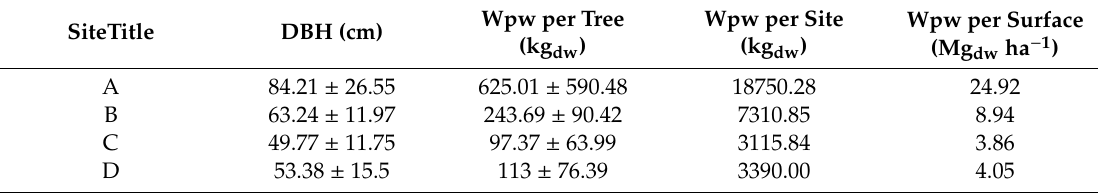
Table 2. Pruning wood biomass (Wpw) produced per tree (Avg. and Std. dev.), per plot, and per